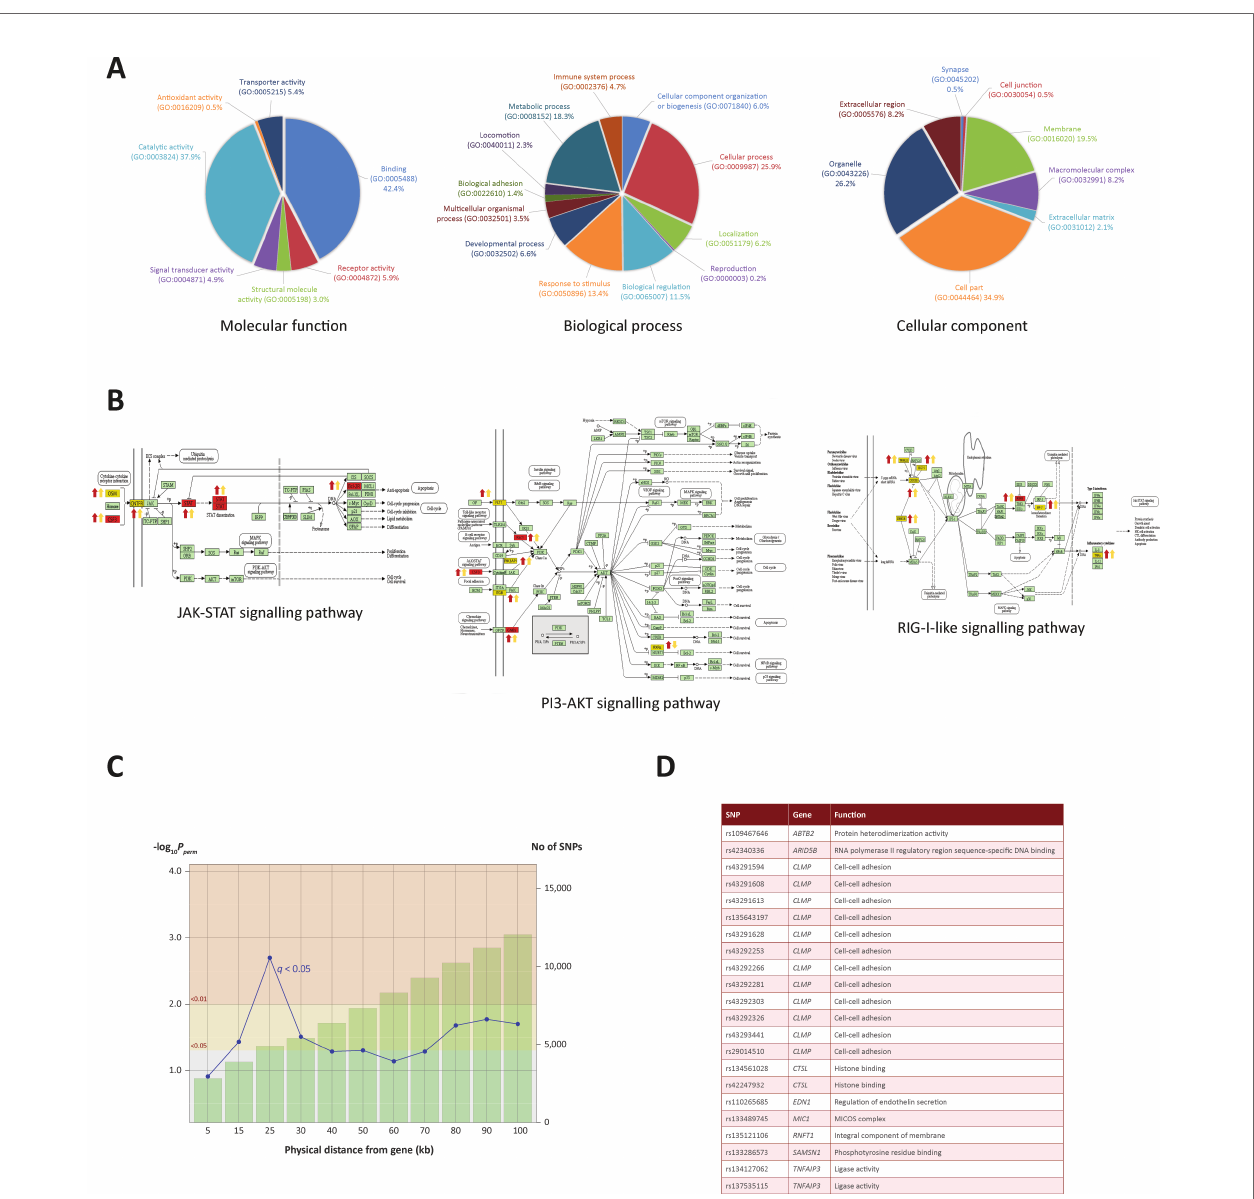
FIGURE 4 | Gene ontology enrichment and pathway analysis. (A) Gene ontology pie charts generated through PANTHER pathway analysis; 232 genes cluster by gene ontology under three main categories: Biological process , Cellular component and Molecular function . (B) KEGG pathway images containing genes identi fi ed from the ChIP-seq and RNA-seq analysis. Gene symbols coloured in yellow were identi fi ed in the ChIP-seq and RNA-seq analysis. Gene symbols coloured in red were also targeted by one or more differentially expressed miRNAs. Up or down red arrows indicate greater H3K4me3 in infected or control, respectively. Up or down yellow arrows indicate log2FC increase or decrease of the associated gene, respectively. (C) Line graph showing different genomic ranges from genes that are enriched for signi fi cant SNPs from GWAS data for bTB resilience. The bars represent the number of SNPs that occupy each range from each ChIP-seq enriched gene, with more SNPs correlating with a greater distance. The blue plotted line represents the negative log 10 probability that the signi fi cant SNPs found at each distance at 0.05 FDR q value are signi fi cant by chance, with SNPs at 25 kb exhibiting the lowest probability. The null SNP P value distribution for each data point was generated from 1,000 permutations of random SNPs corresponding to the number of SNPs observed in a particular genomic range. (D) Genes enriched for SNPs signi fi cantly associated with resilience to M. bovis infection. SNP IDs and functional information obtained from the GeneCards ® database (Stelzer et al., 2016) are also